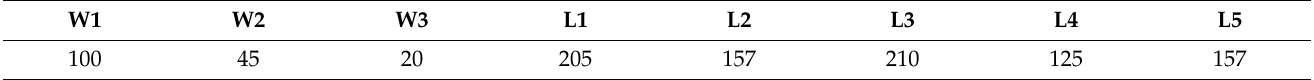
Table 1. Table of graphene pattern layer geometries